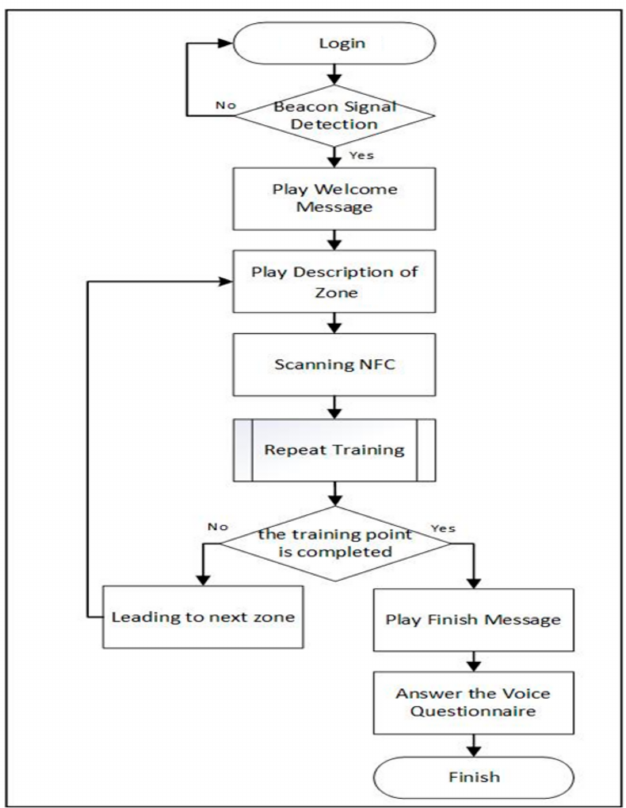
Figure 8. Digital cognitive training flow